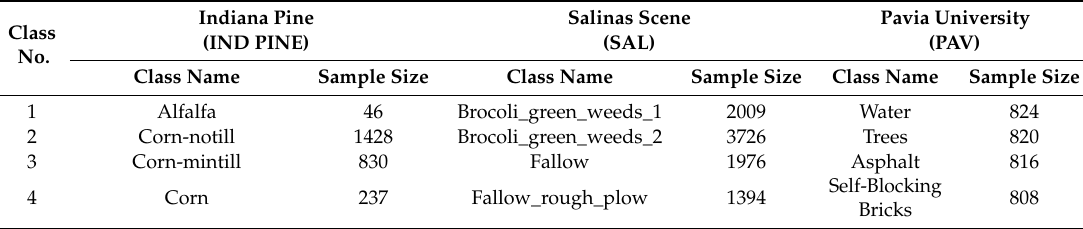
Table 2. Sample size (number of pixels) of each class in datasets from Group